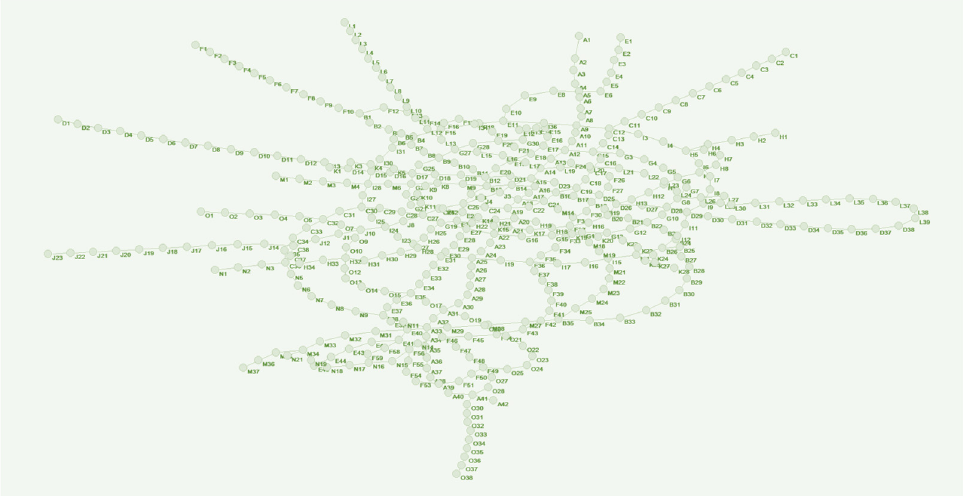
Figure 4. Network topology of the Chengdu rail transit network. There are 450 points in the figure, and each point represents a subway station, while the letters A to O represent the lines 1 to 15.